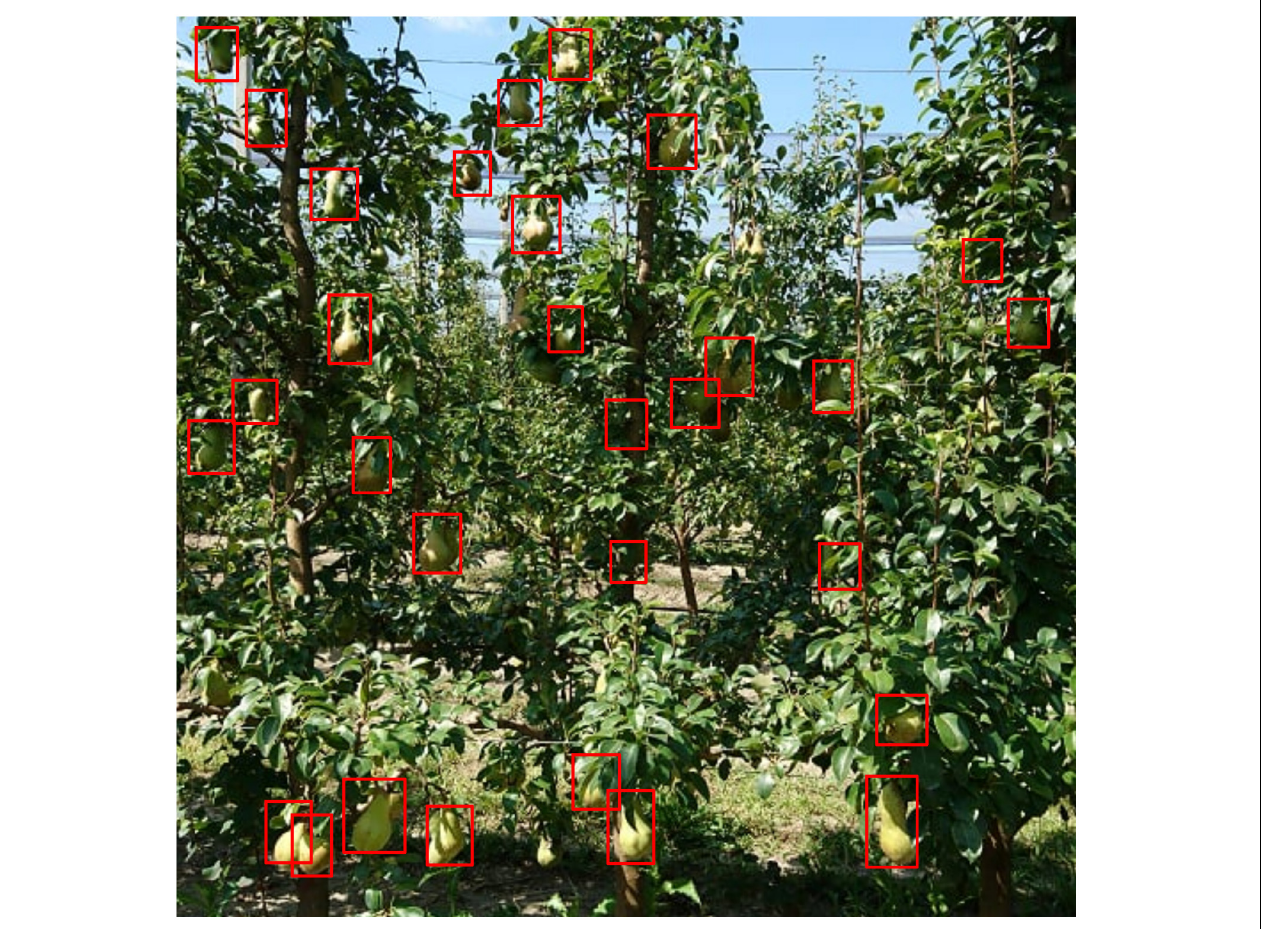
FIGURE 9 | Pears detected from the updated